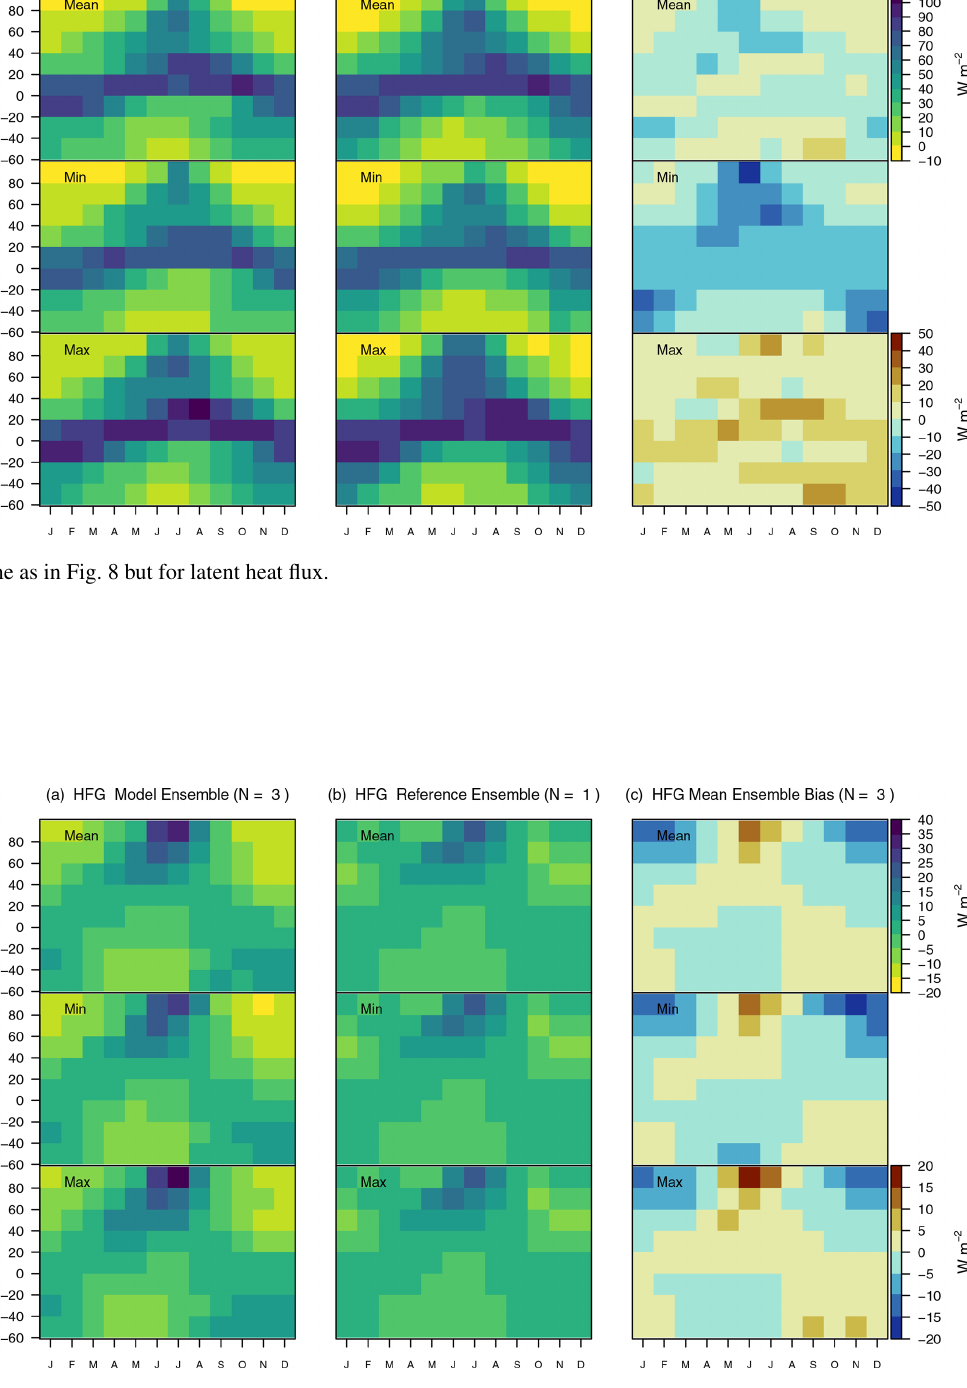
Figure A11. Same as in Fig. 8 but for soil heat